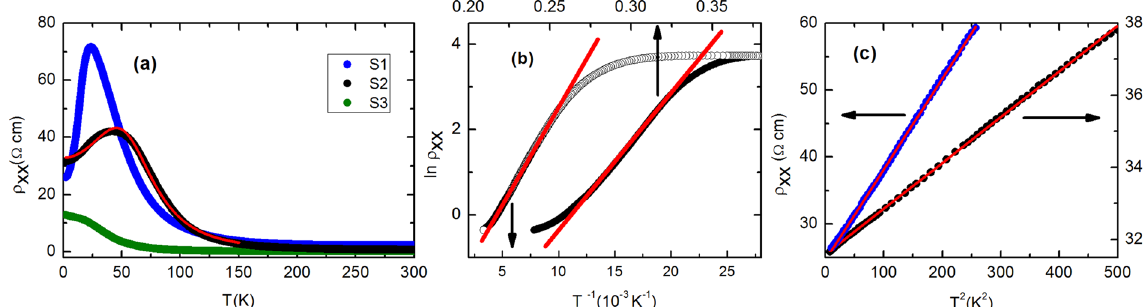
Figure 1. ( a ) Temperature dependence of the resistivity ( ρ xx ) for Bi 1.5 Sb 0.5 Te 1.7 Se 1.3 single crystals collected from two different batches. Crystals S1 and S2 were prepared by method II and S3 was prepared by method I. The red line is the fit to the experimental data with equation ρ xx = [1/ ρ s + 1/ ρ b ] − 1 , where ρ s ( = a + bT 2 ) and   1/4 T ( ) exp     = 0 are respectively surface and bulk resistivity. ( b ) ln ρ ρ ρ  b T 0 bottom axis) for the activation behavior and as a function of T − 1/4 (closed symbol; top axis) for the variable- range-hopping behavior for S2 crystal. ( c ) ρ xx is plotted against T 2 . The linearity can be traced up to 16 K and 21 K for S1 and S2 crystals respectively, confirming the Fermi liquid behavior of the surface